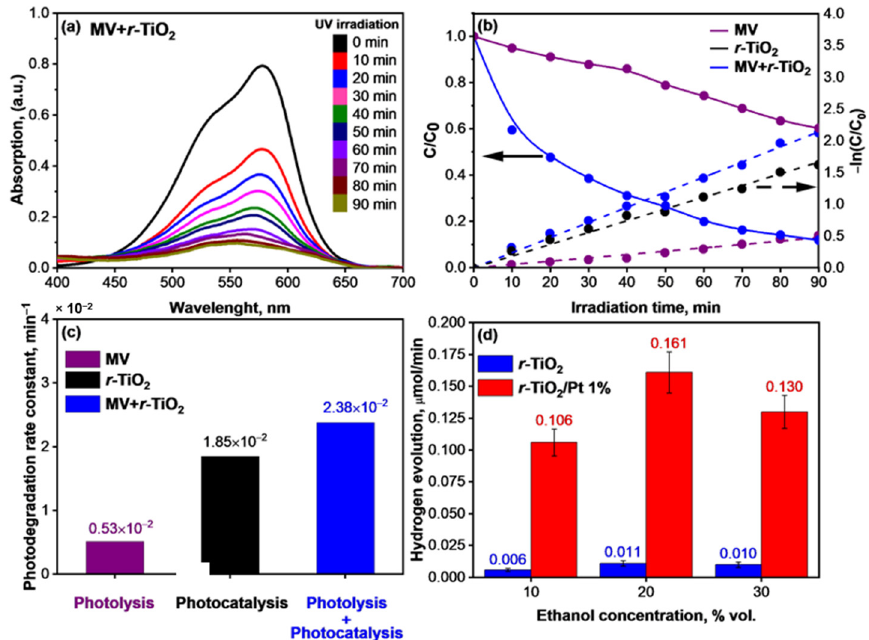
Figure 7. ( a ) Photodegradation of methyl violet aqueous solution in the presence of r -TiO 2 spherulites. ( b ) Normalized and logarithmic kinetics curves of MV photodegradation in the presence and absence of r -TiO 2 spherulites. ( c , d ) Hydrogen evolution rates for aqueous solutions of ethanol with concentrations of 10, 20, and 30 vol% in the presence of r ‐ TiO 2 spherulites and r ‐ TiO 2 /Pt nanocom ‐ posite. Table 1. Structural characteristics of different photocatalysts, their synthesis background, and pho ‐ tocatalytic properties.